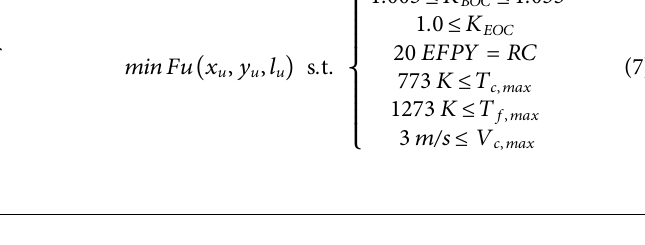
TABLE 9 | Optimized design parameters for